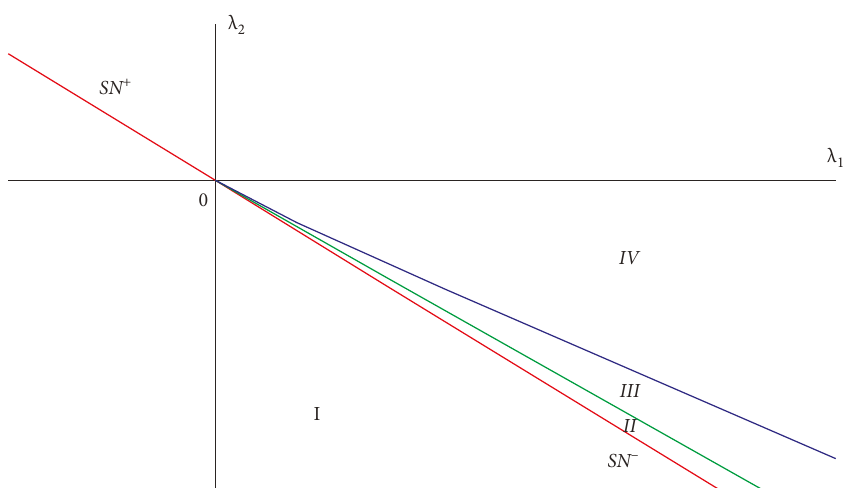
Figure 9: Saddle-node (in red), hopf (in green) and homoclinic (in blue) bifurcation curves in case ( C 2).